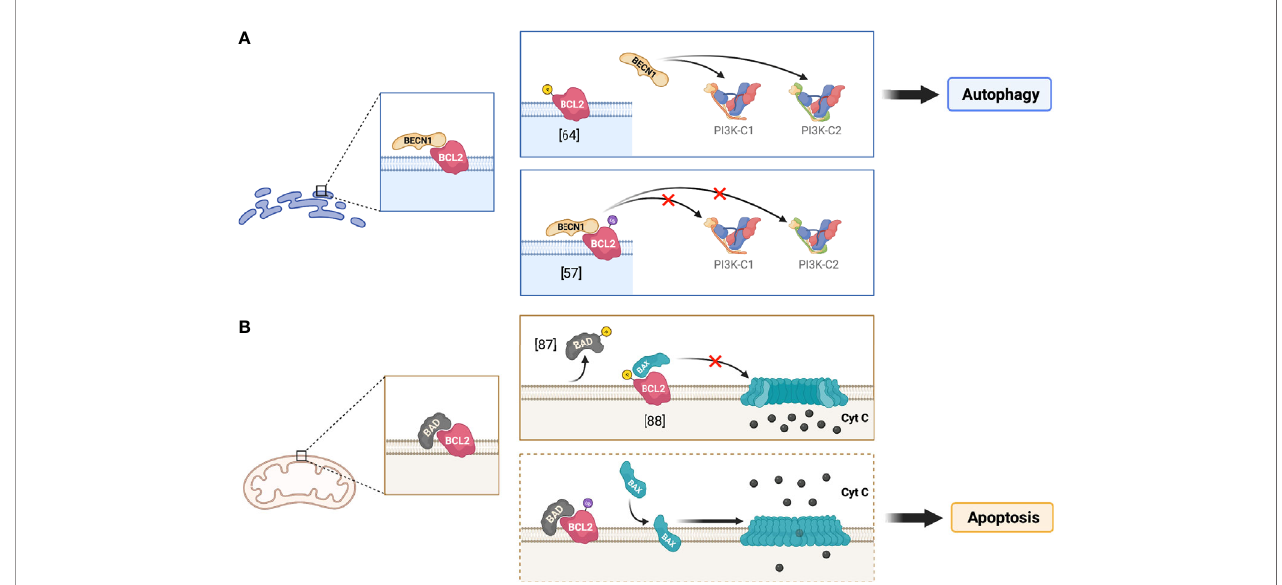
FIGURE 2 | Implications of the phosphorylation and ubiquitination of BCL2 at the ER and mitochondria. The fi gure illustrates the regulation of BCL2 functions through its post-translational modi fi cations at different subcellular localizations, depicting the potential effect of BCL2 ubiquitination on autophagy and apoptosis. (A) presents the roles of BCL2 in the endoplasmic reticulum (ER), whereas (B) depicts the roles of BCL2 at the mitochondria. The dotted frame in (B) represents putative